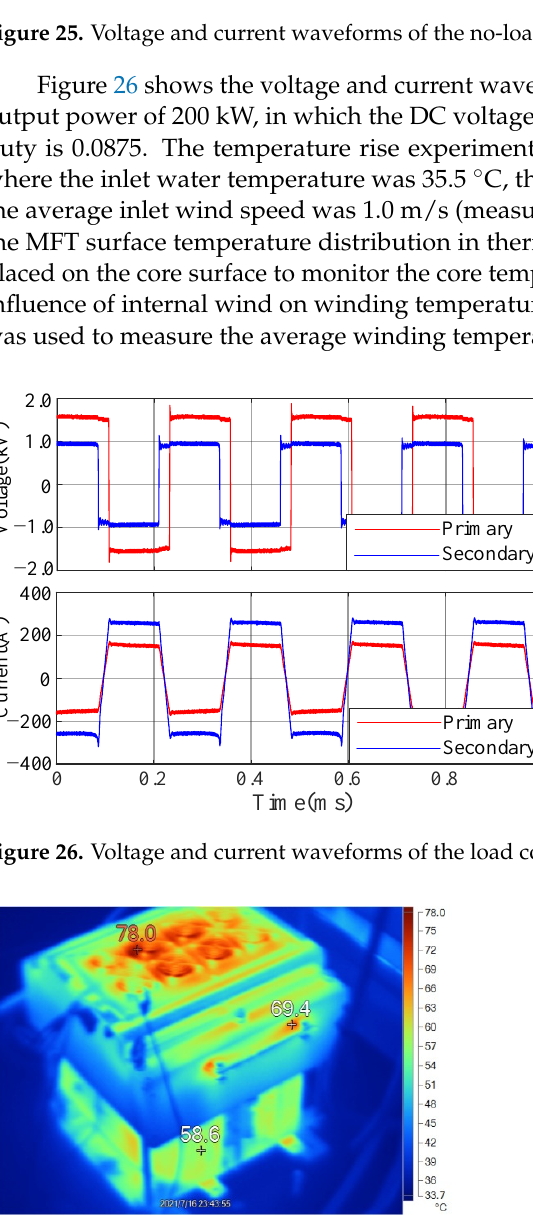
Figure 25. Voltage and current waveforms of the no-load condition.